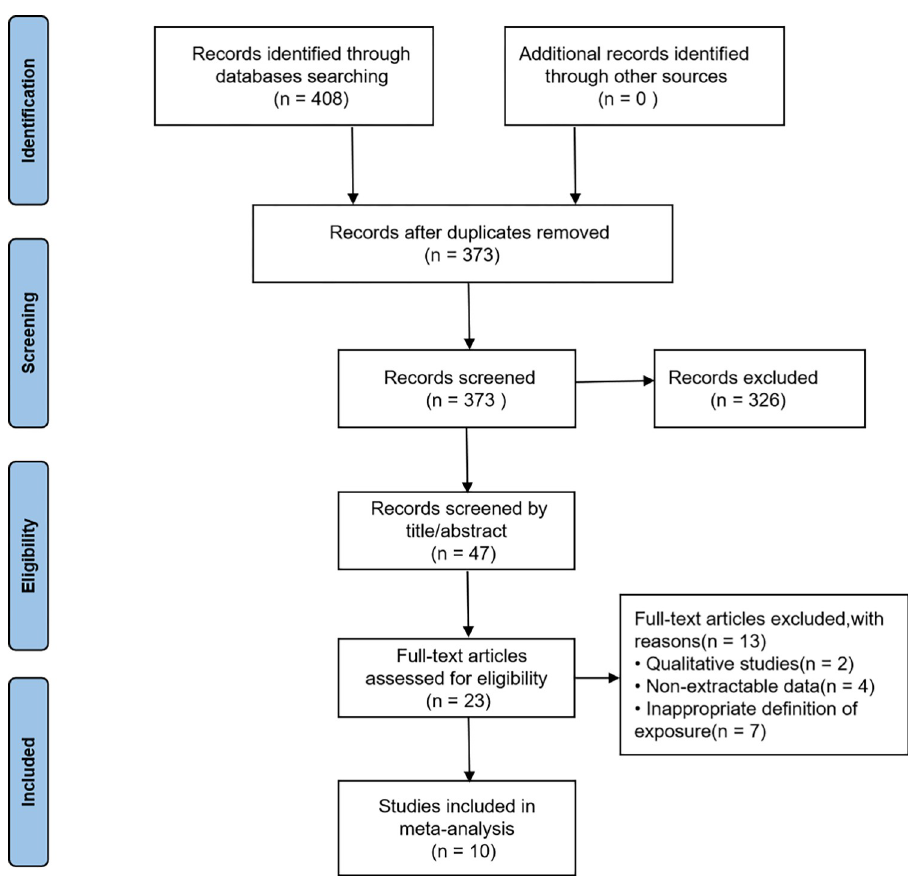
Fig 1. Flow chart of study selection